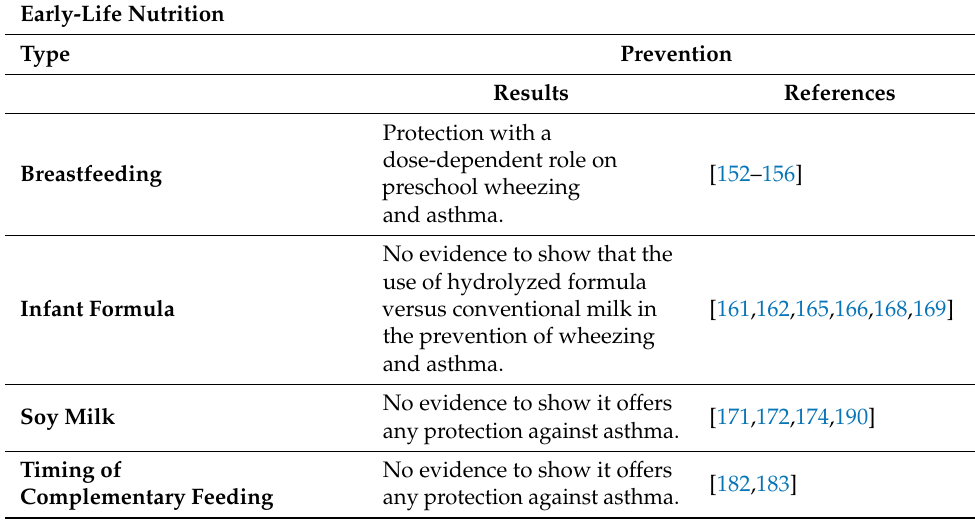
Table 2. Early-life nutritional effects for the prevention of asthma overview.